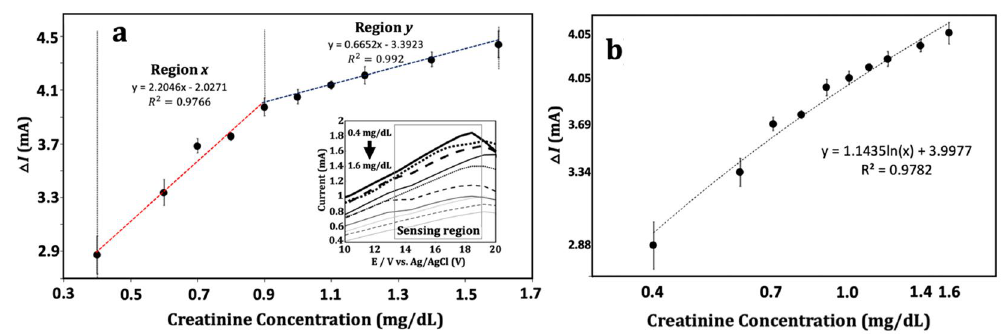
Figure 7. ( a ) Calibration curve ( N = 5) for 3BOBzBT 2 :5CHCl 3 -sensor shows two linear regression regions namely region x , 0.4 mg dL −1 ≤ x ≤ 0.9 mg dL −1 and region y , 0.9 mg dL −1 ≤ y ≤ 1.6 mg dL −1 with correlation coefficients R 2 of 0.977 and 0.992, respectively. ( b ) The log–log calibration curve ( N = 5) with correlation coefficients R 2 of